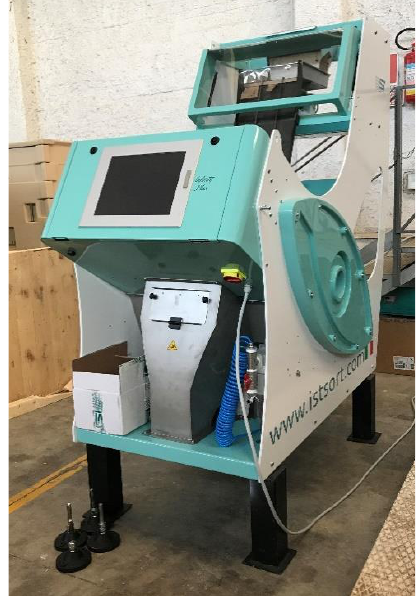
Figure 1. INFINITY PLUS sorting machine.